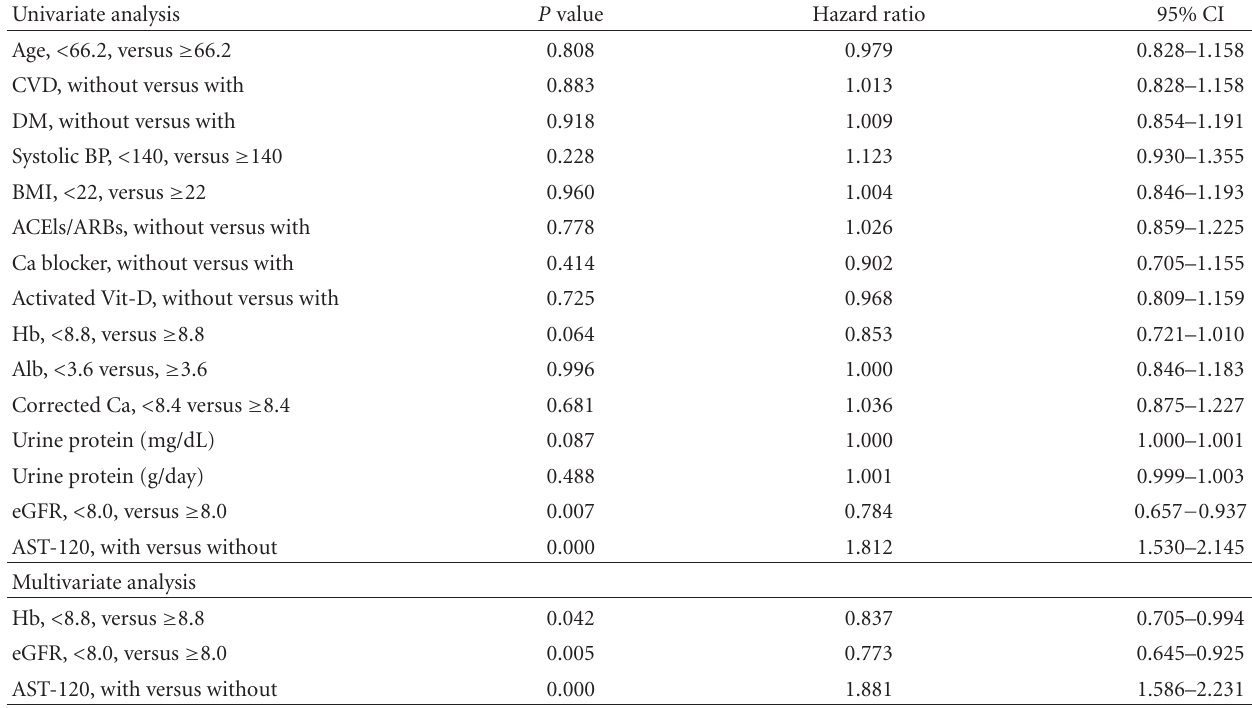
Table 5: Uni- and multivariate analyses of the delaying e ff ect of AST-120 on dialysis initiation. Uni- and multivariate analyses showed anemic status, eGFR, and not receiving AST-120 medication as independent factors associated with a significant increase in risk of dialysis